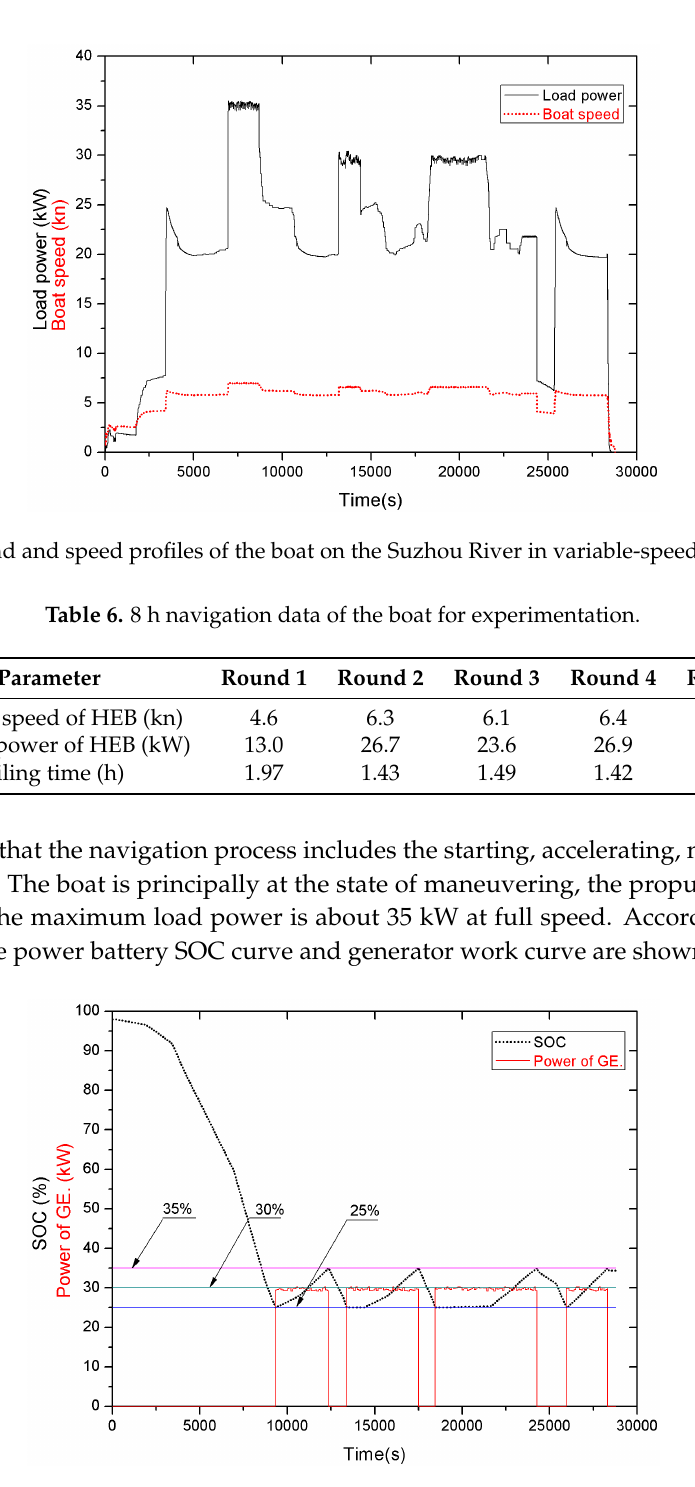
Figure 5. Batteries’ SOC and power of generator profiles in variable-speed